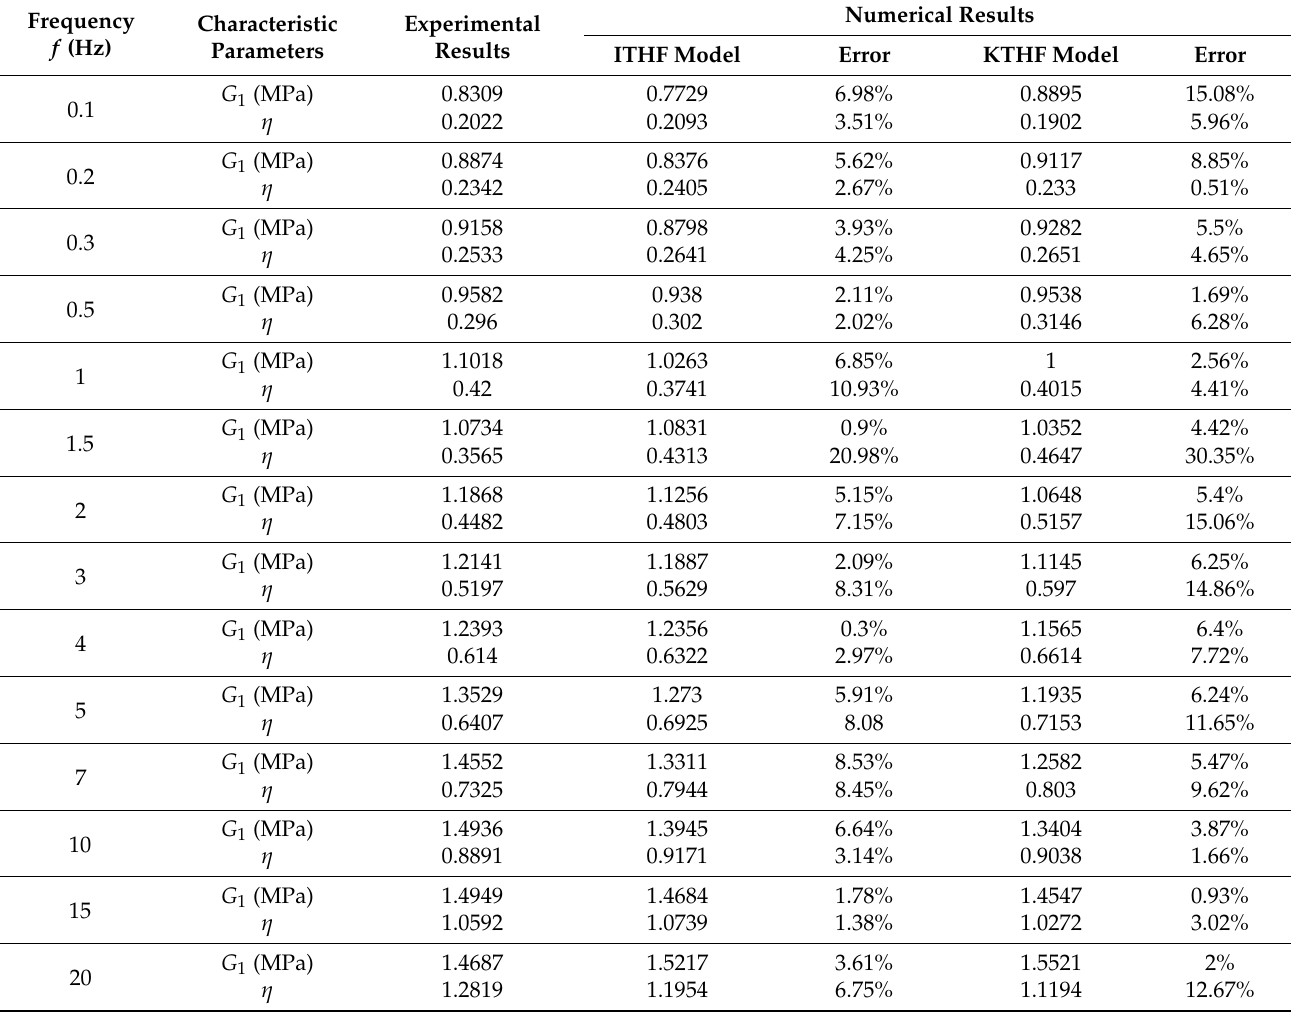
Table 7. The comparisons of the ITHF model and KTHF model when d = 1.0